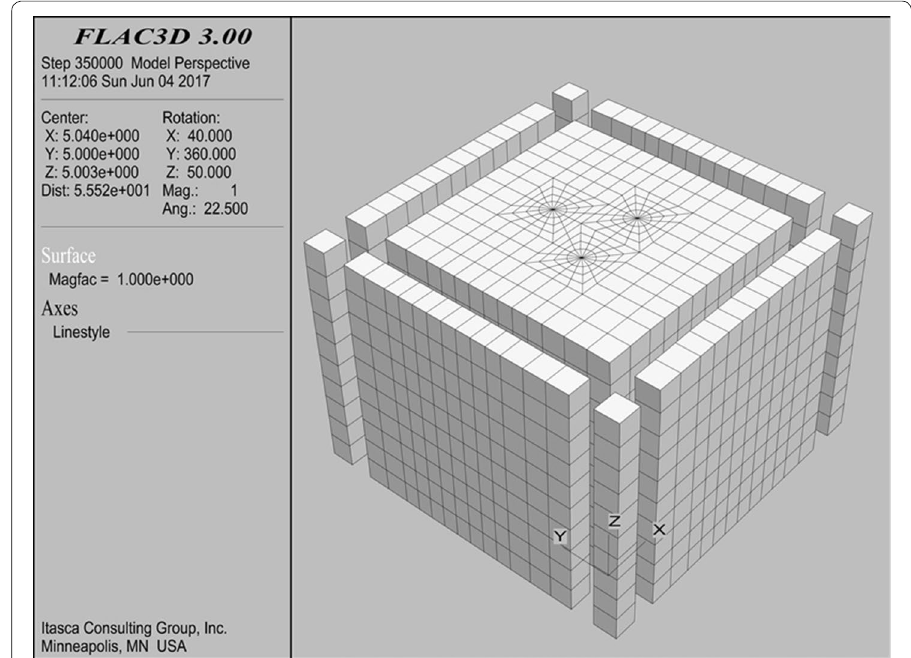
Fig. 15 Finite difference mesh for column